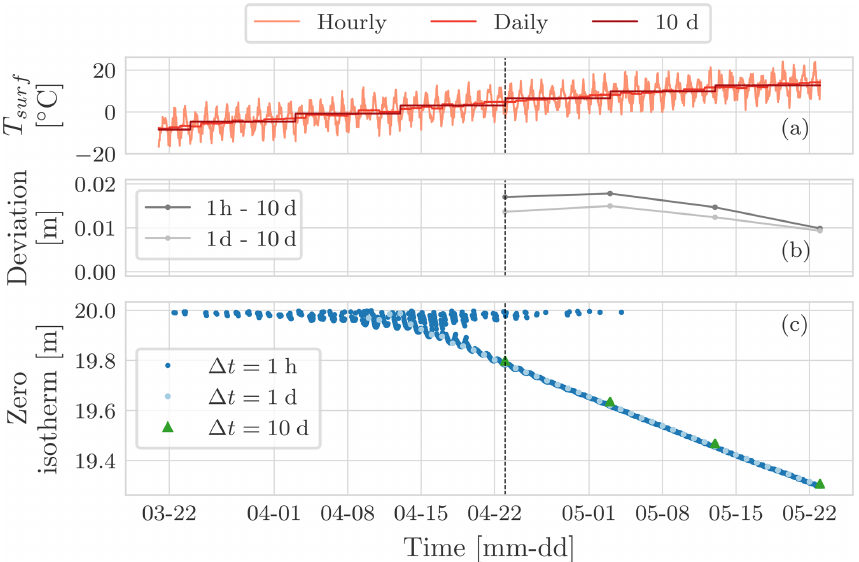
Figure G1. Detail of the beginning of the thawing season for the year 1999. Panel (a) shows the surface temperature for the hourly, the daily, and the 10d simulations. Panel (b) shows the deviation of the position of the zero isotherm after 100 years between the hourly and the 10d simulation, as well as between the daily and the 10d simulation. Panel (c) shows the position of the zero isotherm after 100 years for the three simulations. In panel (b) there is a time lag of about 1 month between the beginning of thawing season for the hourly simulation and the 10d one (dashed grey line). This can be attributed to the different surface temperature used to drive the simulations.